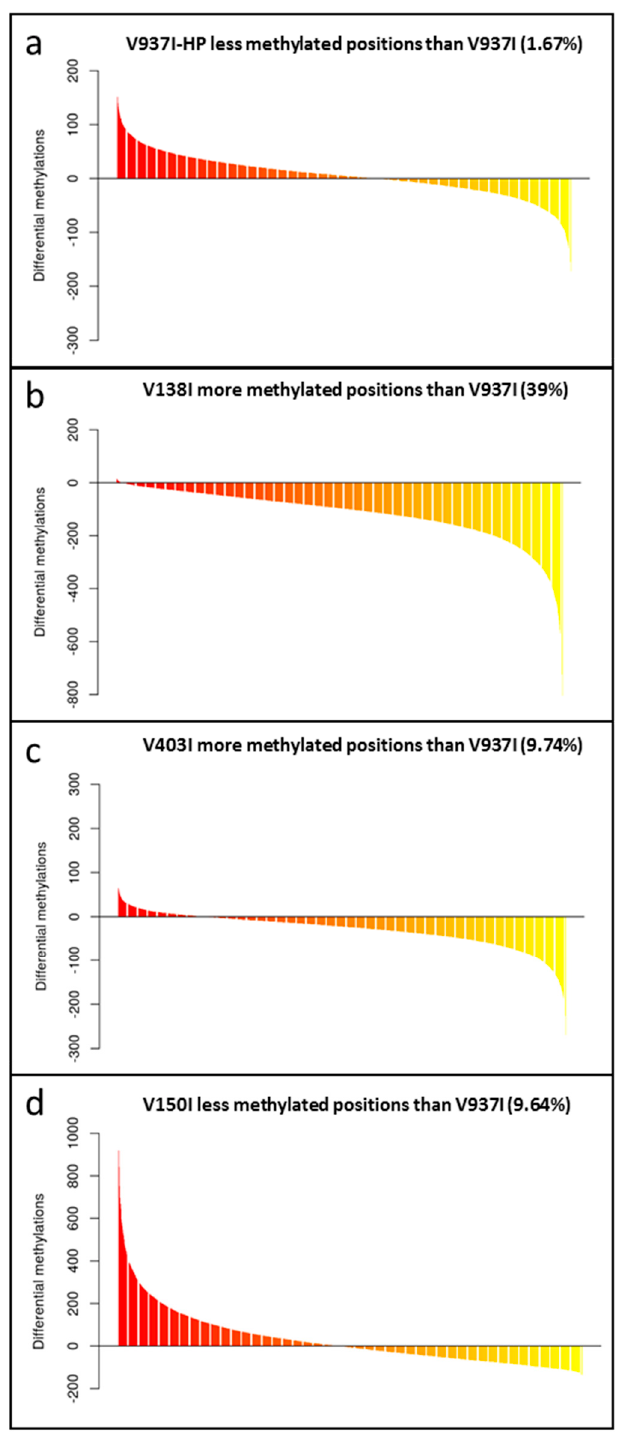
Figure 2. The gene methylation pattern of the Verticillium dahliae isolates compared to the reference V937I isolate. The average methylation % differences of the protein-coding gene sequences compared to reference isolate V937I are represented from the more positive to more negative values. Isolate V397I-HP is represented in ( a ), V138I in ( b ), V403I in ( c ) and V150I in ( d ). Data correspond to two bisulfite-treated sequenced DNA samples, except for the V397I-HP derived isolate, for which only one sample was available.